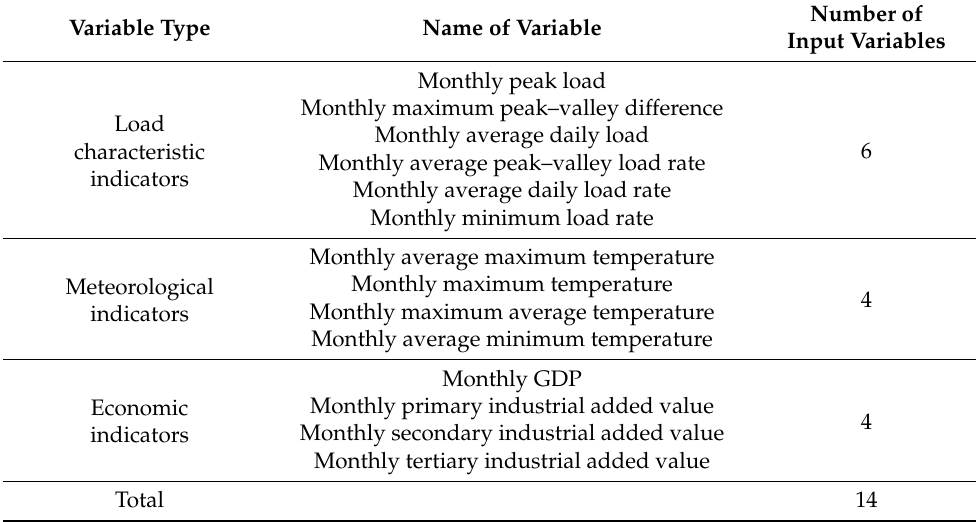
Table 1. Input variables related to the peak